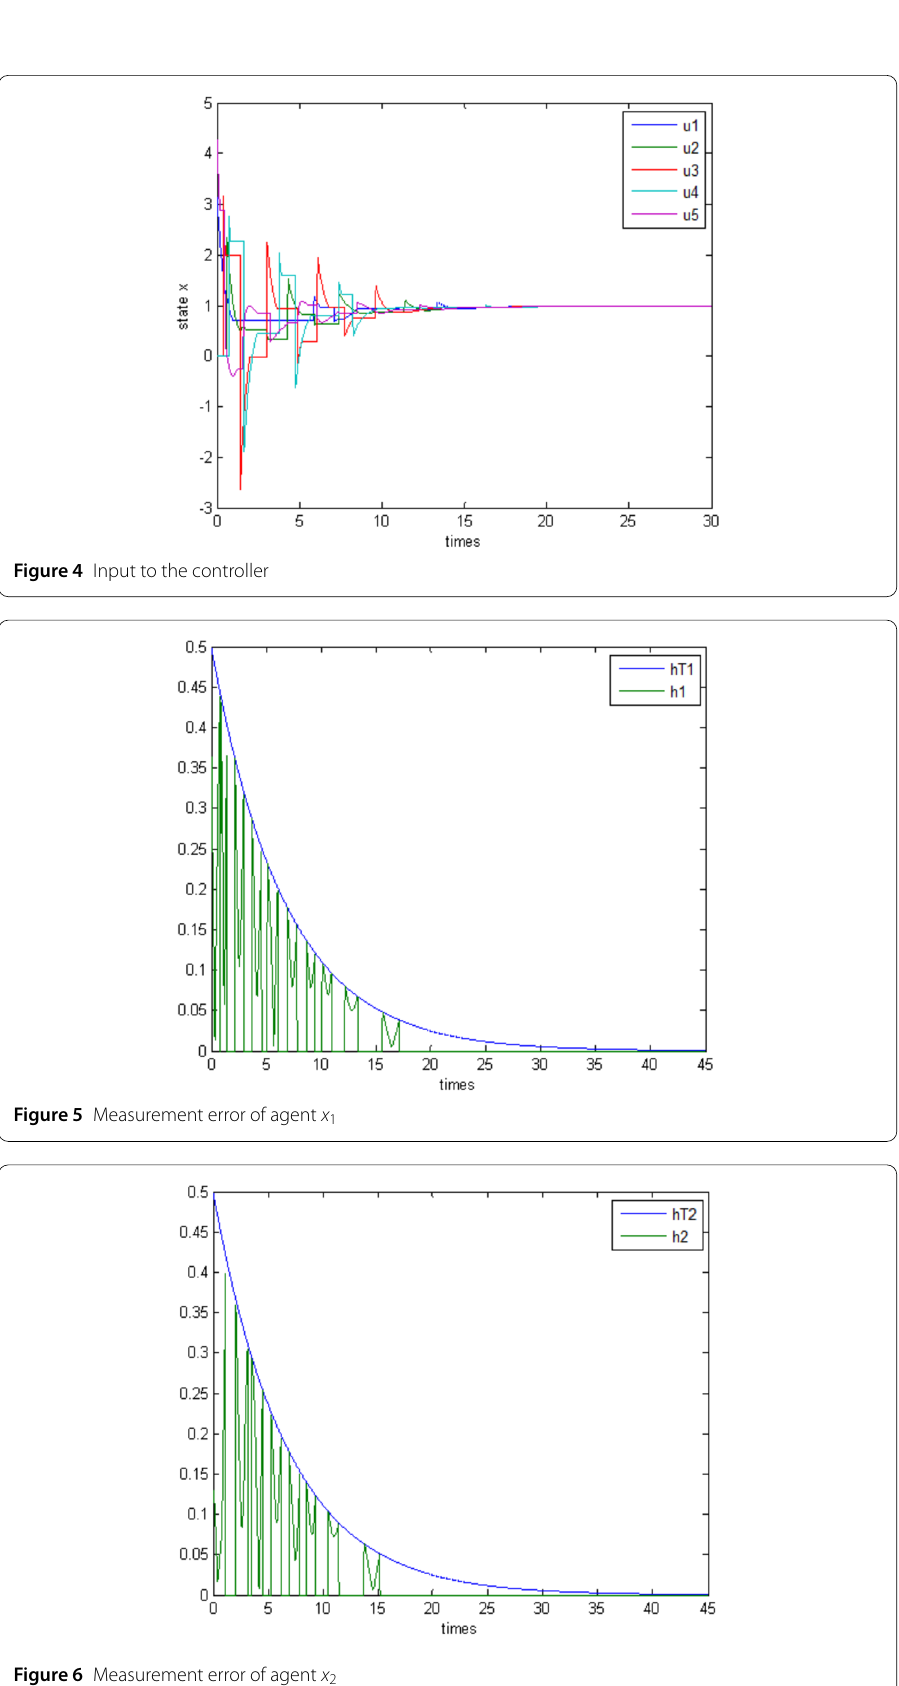
Figure 6 Measurement error of agent x